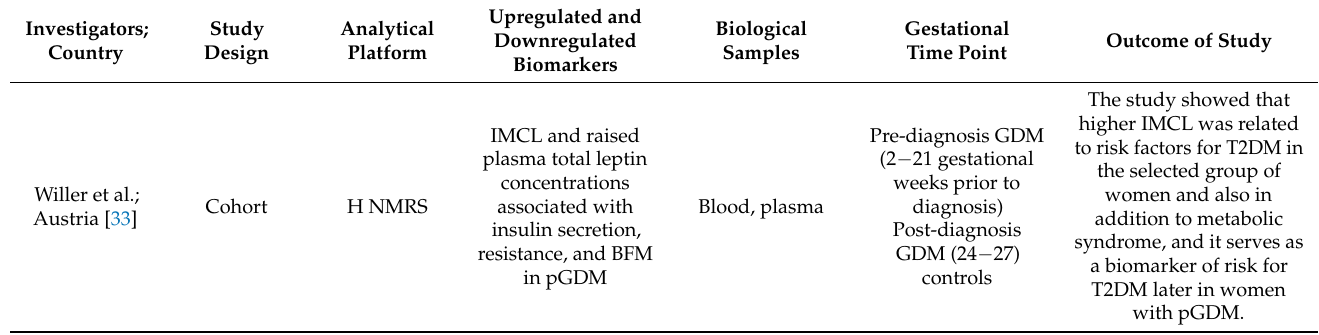
Table 2. The outcome of studies, specific biomarkers at different gestational time points, biological samples, and the relevant spectroscopy techniques